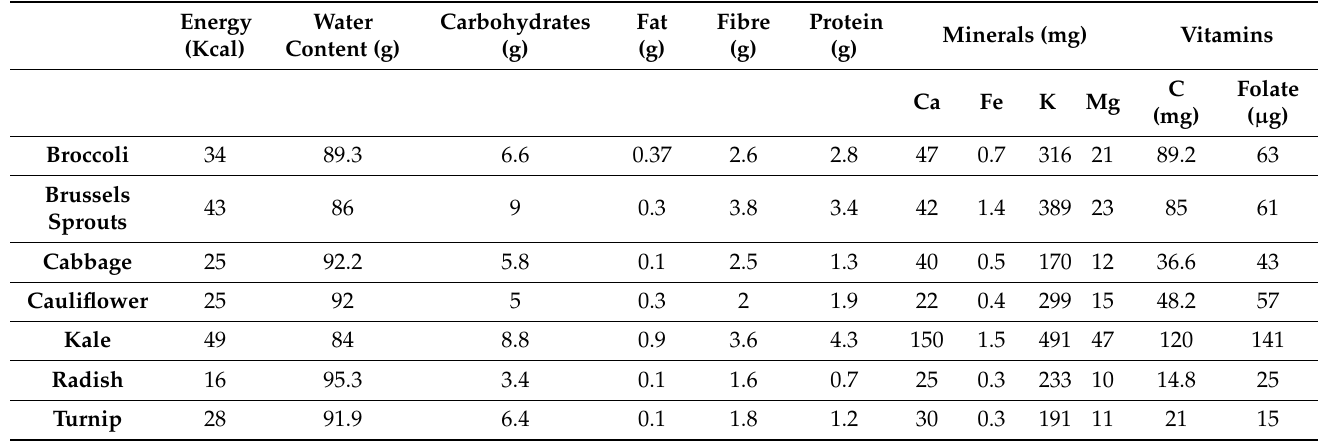
Table 1. Nutritional composition of Brassica vegetables per 100 g